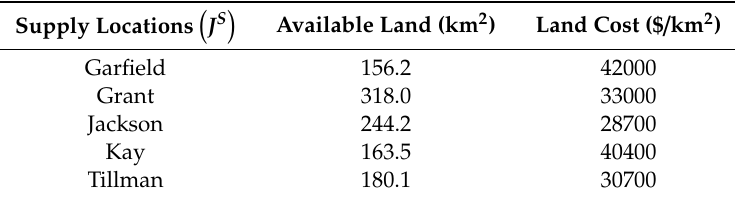
Figure 8. Counties of Oklahoma, with green outlines indicating a county is considered as a potential supplier of algal biomass based on having the top 25% of well depth. Base map from U.S. Census Bureau [26].